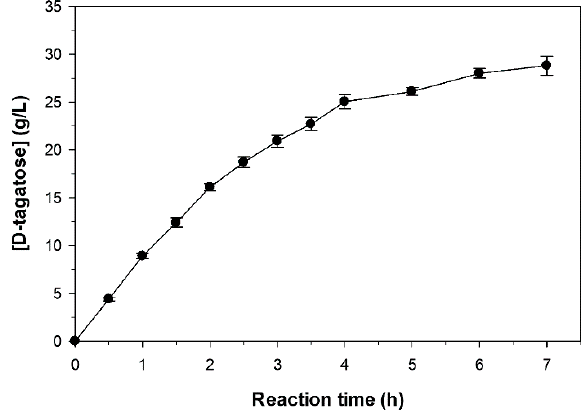
Figure 7. Progress of formation of D-tagatose from D-galactose syrup obtained by hydrolysis of whey permeate. Experimental conditions: 90 g / L D-galactose (coming from 180 g / L lactose in whey permeate), 0.65 U / mL L-arabinose isomerase US100, 0.5 mM MnSO 4 , pH 7.5, 65 ◦ C.